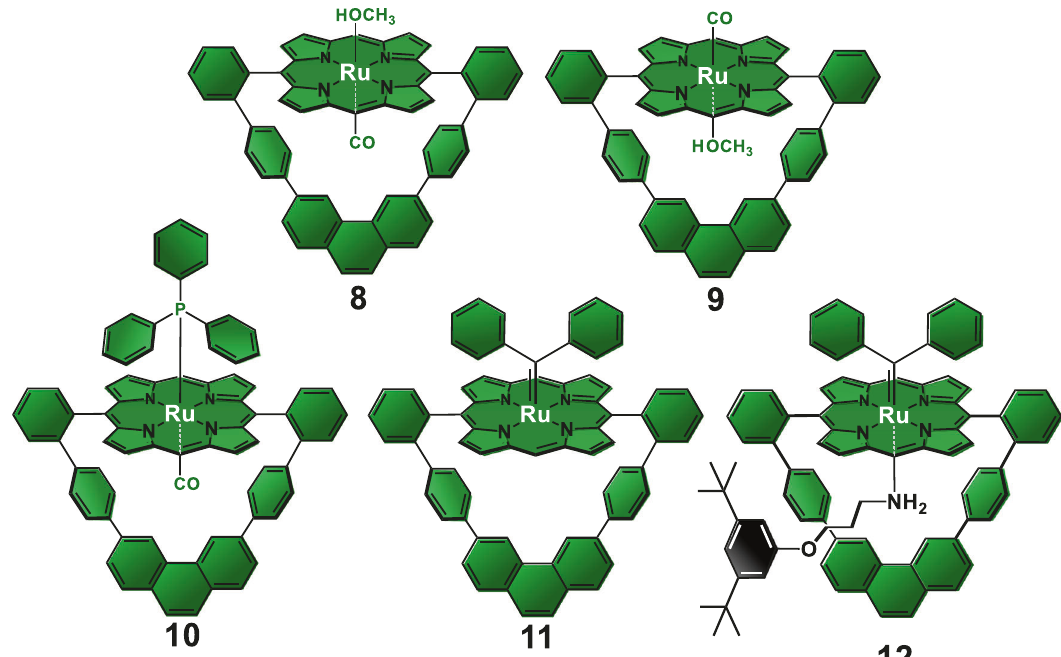
Fig. 3 Molecular structures of the Ru(II)porphyrinate complexes. Complex 9 is not observed in our